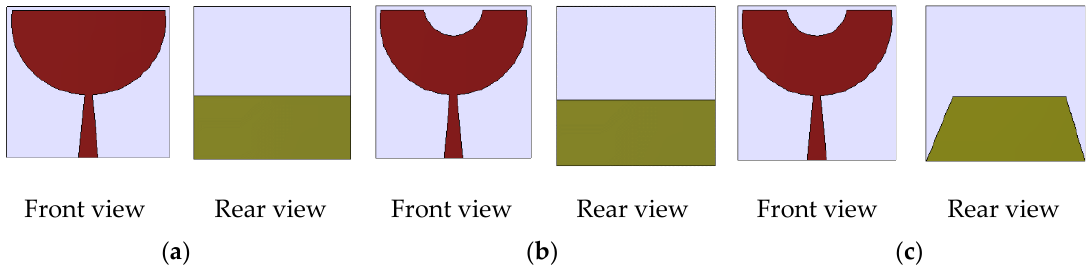
Figure 3. Different modifications of the proposed prototype: ( a ) Normal patch design; ( b ) Slotted patch design; ( c ) Proposed design.